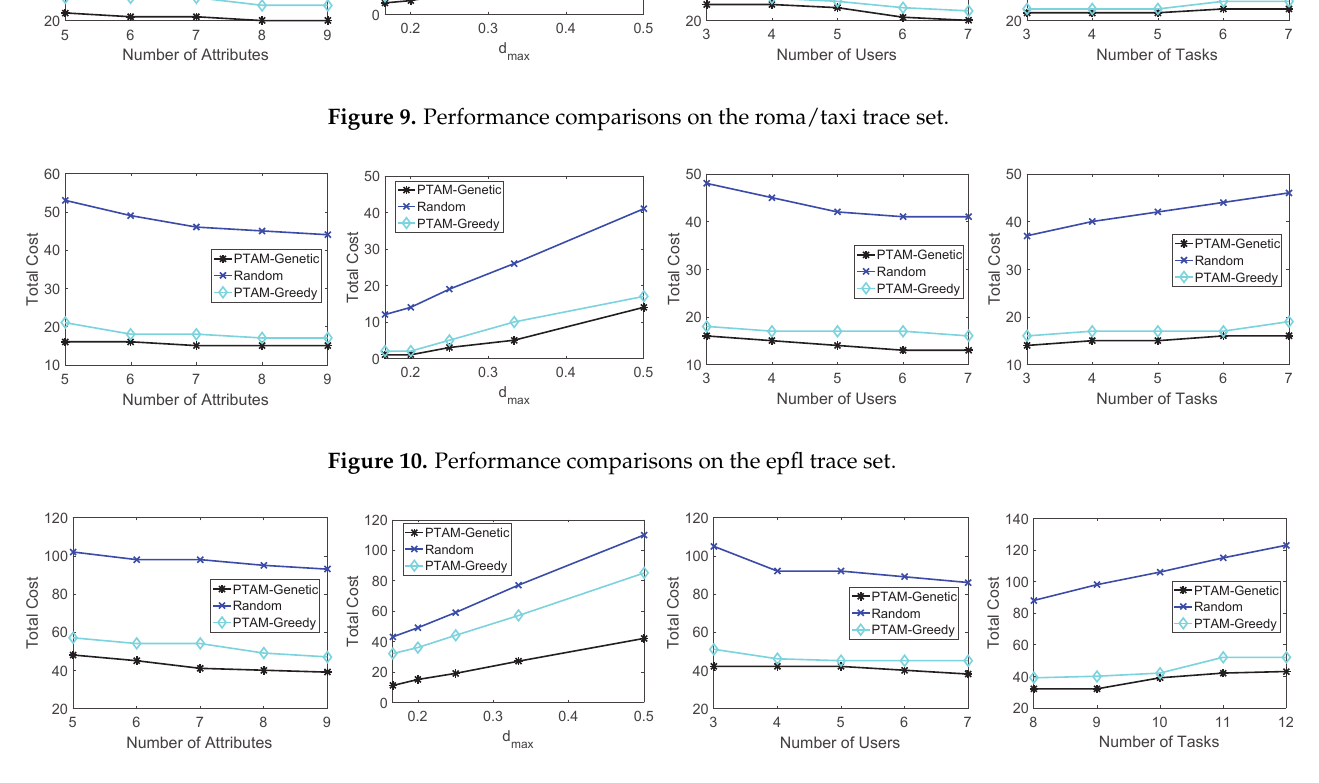
Figure 11. Performance comparisons on the geolife trace